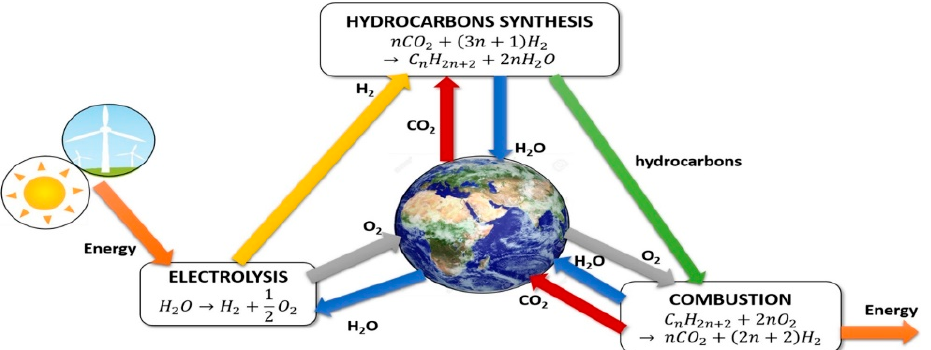
Figure 1. Concept of power-to-liquid or power-to-gas for the production of synthetic fuels (re-used with permission from C. Panzone et al. [6]).